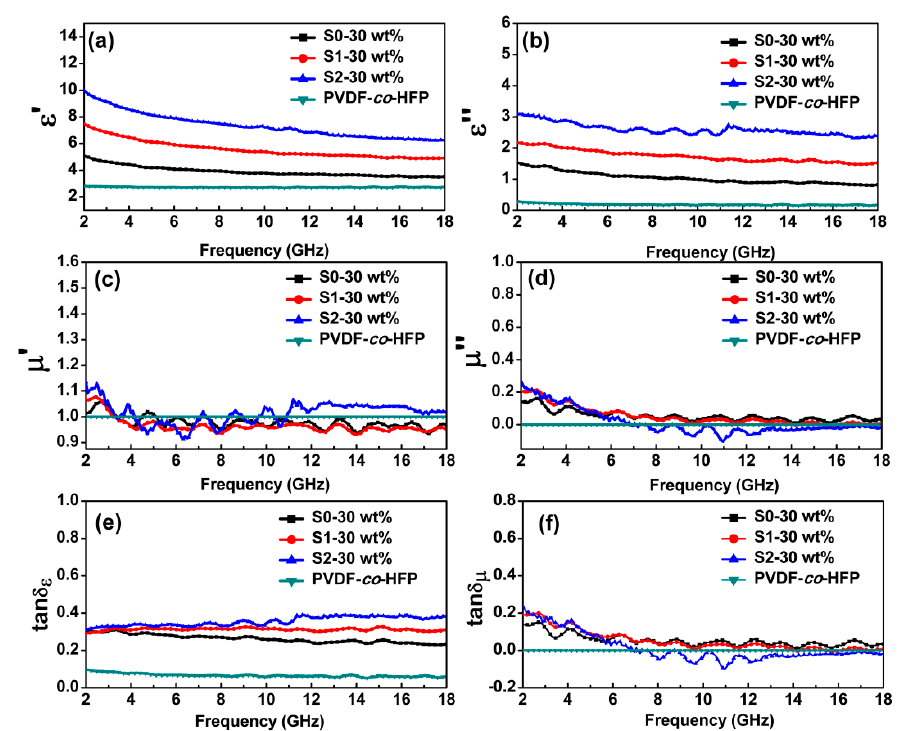
Figure 4. Frequency dependence of the EM parameters of all the samples: ( a ) real permittivity, ( b ) imaginary permittivity, ( c ) real permeability, ( d ) imaginary permeability, ( e ) dielectric loss, and ( f ) magnetic loss.